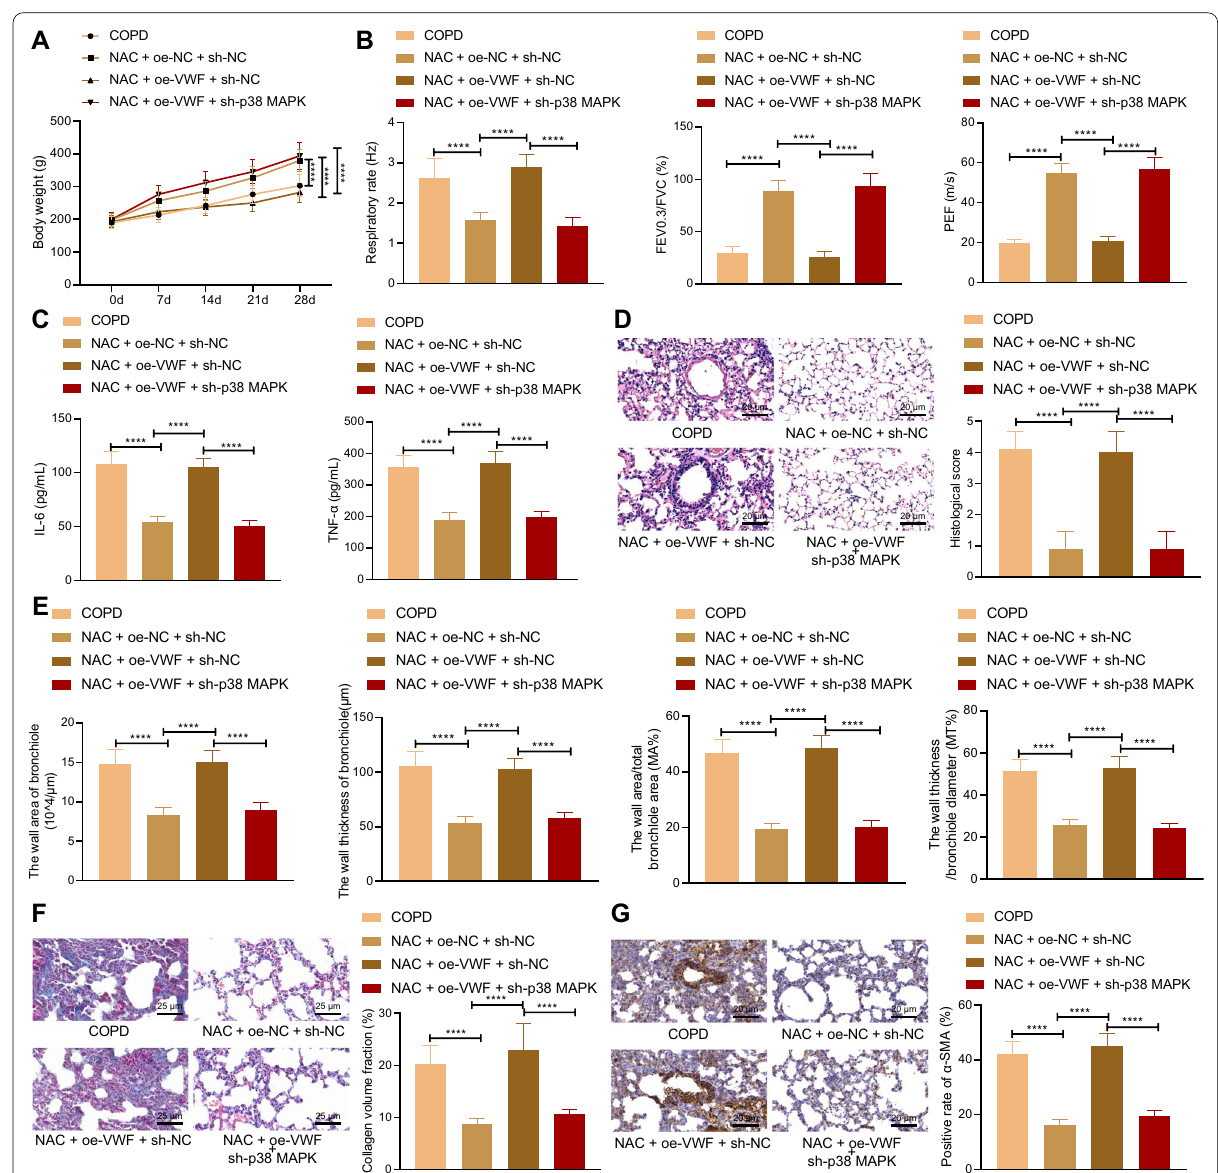
Fig. 7 NAC relieves pulmonary fibrosis caused by COPD through the VWF/p38 MAPK axis. COPD rats were treated with NAC and oe-VWF and/ or sh-p38 MAPK (n 10). A The weight of COPD rats. B Pulmonary function of COPD rats. C Levels of IL-6 and TNF-α in the serum of COPD rats = measured by ELISA. D Histological score of COPD rats detected by HE staining. E Bronchioles area, thickness bronchioles, the wall area/total bronchiole area (MA%) and the wall thickness/bronchiole diameter (MT%) of COPD rats. F Collagen volume fraction in lung tissues of COPD rats detected by Masson’s trichrome stain. G α-SMA level in lung tissues of COPD rats detected by Immunohistochemistry. Cells were treated with CSE and PBS or CSE and NAC. **** p < 0.0001. Data are shown as the mean standard deviation of three technical replicates. Data among multiple ± groups were compared by one-way ANOVA with Tukey’s post hoc test. Data at different time points were compared by two-way ANOVA with Bonferroni post hoc macrophages, bronchial epithelial cells, pulmonary et al., 1985; Gaffey et al. 2013). p38 MAPK activation lymphocytes and quadriceps femoris cells in patients is also involved in local and systemic inflammation with COPD suggest that the activation of MAPK path- of COPD (Watz et al. 2014). Inhibition of p38 MAPK reduces the production of cytokines secreted by several way is involved in the pathogenesis of COPD (Lemire lung and blood cells in COPD (Armstrong et al. 2011;